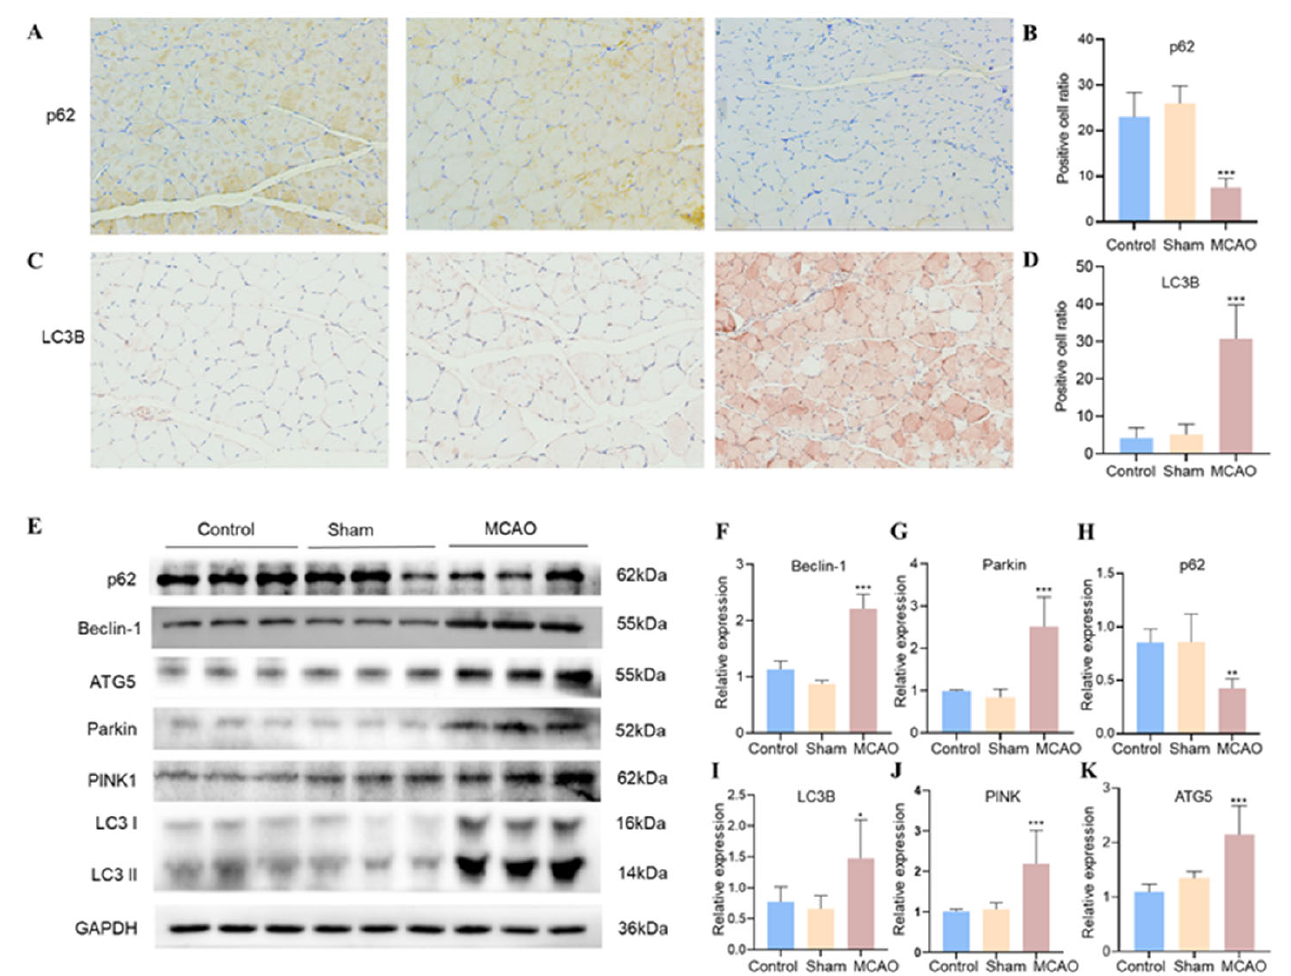
Figure 6. Expression of autophagic proteins in soleus muscle. ( A ) Immunohistochemical analysis of paraffin-embedded soleus tissue slide using p62 antibody. ( B ) p62 positive cell ratio. ( C ) Immunohistochemical analysis of paraffin-embedded soleus tissue slide using p62 antibody. ( D ) LC3B positive cell ratio. ( E ) Western blot bands showing the protein expression levels of p62, Beclin-1, ATG5, Parkin, PINK, LC3BI, LC3BII, and GAPDH. ( F – K ) Relative protein expression for p62, Beclin-1, Parkin, PINK, LC3BI, LC3BII, and GAPDH was quantified by densitometry based on immunoblot images ( n = 6). * p < 0.05, ** p < 0.01, *** p < 0.001 vs. There was no significant difference between the control group and the sham group.